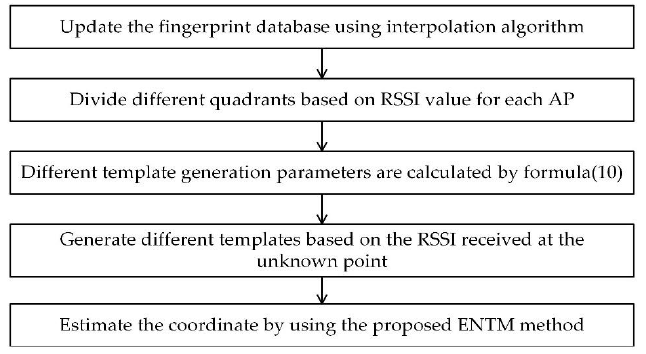
Figure 9. The flow chart of fingerprint indoor localization method based on the proposed eight- neighborhood template matching (ENTM) method.